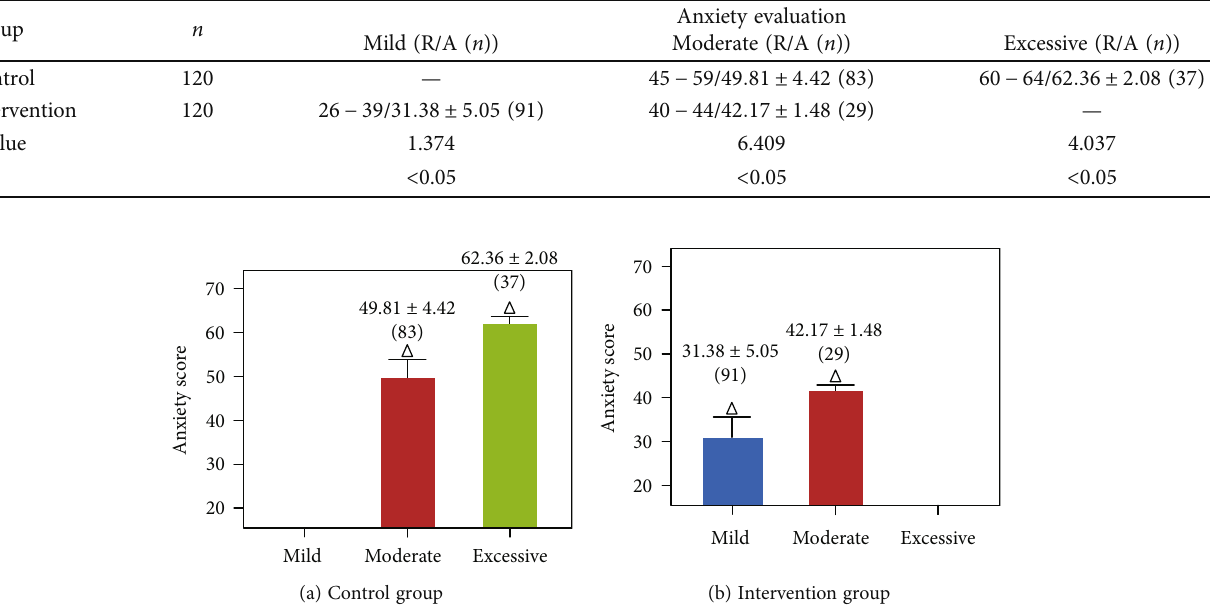
Table 3: Comparison of anxiety evaluation results of college students in the control and intervention groups after treatment ( (cid:1) x ± s ). Note: R: range; A: average; n : number of students.